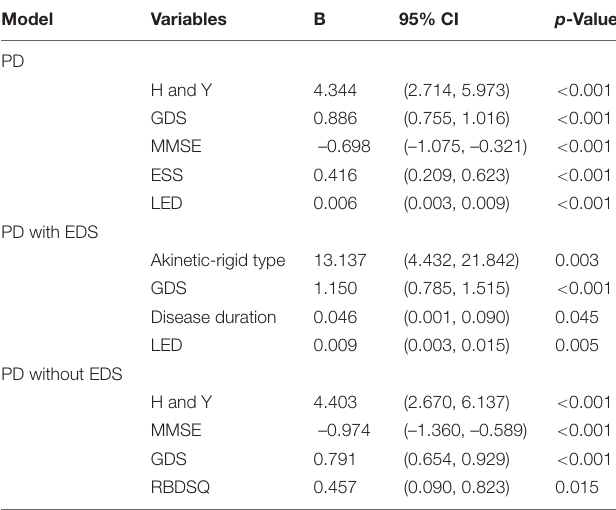
TABLE 4 | Predictors of QoL in PD patients with and without EDS using generalized linear mixed models.